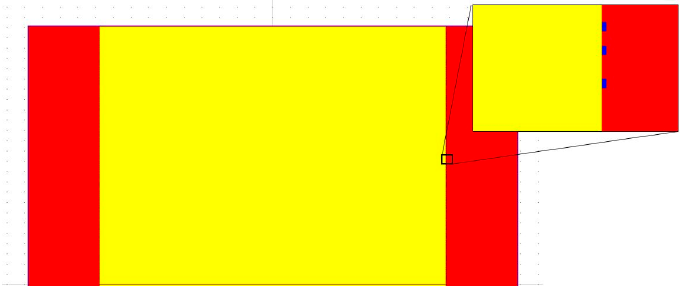
Figure 3. Simulation model of a fiber implemented in BeamPROP in order to simulate a gradual increase of bacteria density (blue rectangles with RI = 1.39) adhered to the fiber surface. The yellow area is the fiber core and the red area the surrounding water.